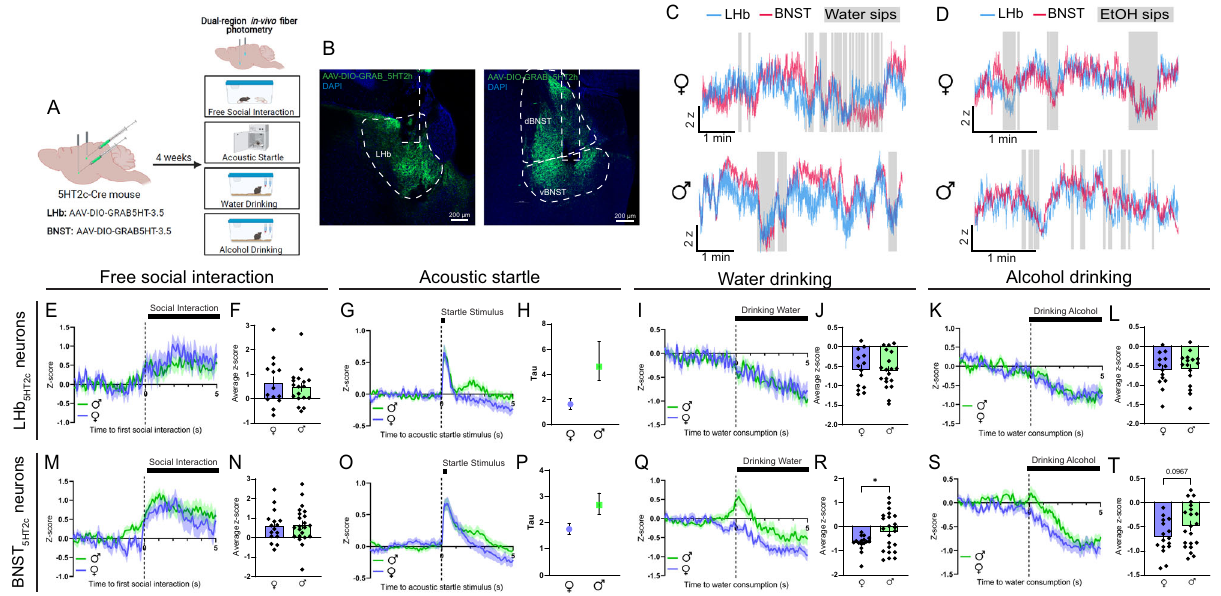
Fig. 2 | In-vivo LHb 5HT2c and BNST 5HT2c serotonin signals are modulated by 1 – 4 bouts). M Peri-event plot of BNST 5HT2c GRAB-5HT activity during the fi rst exposuretoaffectivestimuli.A Surgicalschematicandexperimentaltimelinefor interaction with a novel juvenile social target (Females: n =16 mice/1 trial; Males: n =21mice/1 trial). N Average z-score of BNST – 5s post GRAB-5HT fi ber photometry experiments. B Representative viral infections and 5HT2c GRAB-5HT signal for 0 fi ber placements in LHb (left) and BNST (right). Similar viral placement was interaction(Females: n =16mice/1trial;Males: n =21mice/1trial). O Peri-eventplot reproduced in n =39 mice. C , Representative traces for water drinking session. of BNST 5HT2c GRAB-5HT activity during the acoustic startle test (Females: n =16 D Representative traces for alcohol drinking session. E Peri-event plot of LHB 5HT2c mice/10 trials; Males: n =21 mice/10 trials). P Tau (time constant) of BNST 5HT2c GRAB-5HT activity during the fi rst interaction with a novel juvenile social target GRAB-5HT signal for 0-5s post startle stimulus ( fi t with one phase exponential (Females: n =14 mice/1 trial; Males: n =18 mice/1 trial). F Average z-score of decay curve, bars depict 95% con fi dence interval) (Females: n =16 mice/10 trials; LHb 5HT2c GRAB-5HT signal for 0-5s post interaction (Females: n =14 mice/1 trial; Males: n =21 mice/10 trials). Q Peri-event plot of BNST 5HT2c GRAB-5HT activity Males: n =18 mice/1 trial). G Peri-event plot of LHb 5HT2c GRAB-5HT activity during duringvoluntarywaterconsumption(Females: n =16mice/1 – 4bouts;Males: n =23 the acousticstartle test(Females: n =14mice/10 trials;Males: n =18mice/10trials). mice/1 – 4 bouts). R Average z-score of BNST 5HT2c GRAB-5HT signal for 0 – 5s post H Tau (time constant) of LHb 5HT2c GRAB-5HT signal for 0-5s post startle stimulus water drinking bout start, p =0.0331(Females: n =16 mice/1 – 4 bouts; Males: n =23 ( fi t with one phase exponential decay curve, bars depict 95% con fi dence interval) mice/1 – 4bouts). S Peri-eventplotofBNST 5HT2c GRAB-5HTactivityduringvoluntary (Females: n =14 mice/10 trials; Males: n =18 mice/10 trials). I Peri-event plot of alcohol consumption (Females: n =16 mice/1-4 bouts; Males: n =21 mice/1 – 4 LHb 5HT2c GRAB-5HT activity during voluntary water consumption (Females: n =14 bouts). T Average z-score of BNST 5HT2c GRAB-5HT signal for 0 – 5s post water mice/1-4 bouts; Males: n =19 mice/1 – 4 bouts). J Average z-score ofLHb 5HT2c GRAB- drinking bout start (Females: n =16 mice/1 – 4 bouts; Males: n =21 mice/1 – 4 bouts). 5HTsignalfor0 – 5spostwaterdrinkingboutstart(Females: n =14mice/1 – 4bouts; Unlessotherwisestated,statisticalcomparisonswereperformedusingatwo-tailed Student ’ s unpaired t test. All data excluding panels 2H and 2P are represented as Males: n =19 mice/1-4 bouts). K Peri-event plot of LHb 5HT2c GRAB-5HT activity during voluntary alcohol consumption (Females: n =14 mice/1 – 4 bouts; Males: mean±SEM. * p <0.05, ** p <0.01. Source data are provided as a Source Data fi le. n =16 mice/1 – 4 bouts). L Average z-score of LHb – 5s Created with 5HT2c GRAB-5HT signal for 0 postalcoholdrinkingboutstart(Females: n =14mice/1-4bouts;Males: n =16mice/